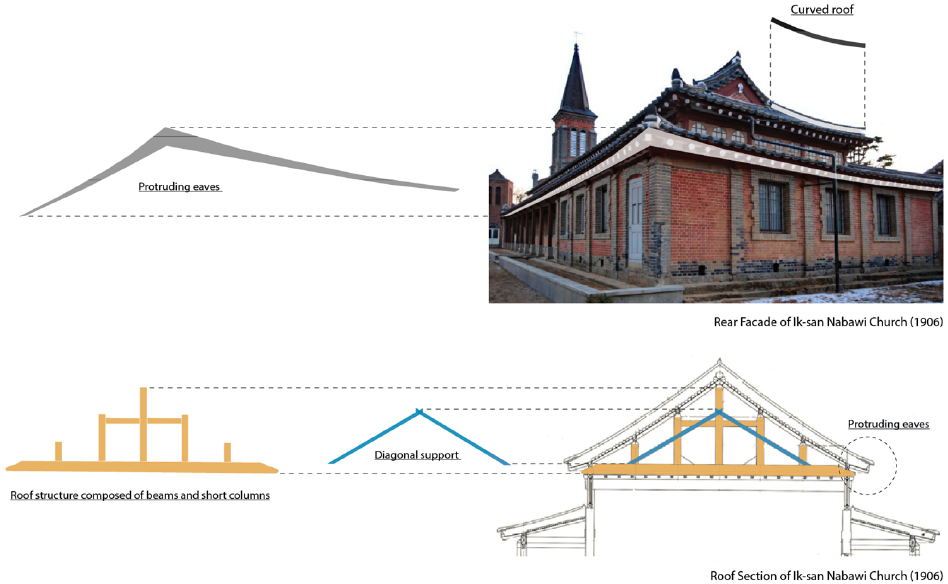
Figure 5. ( Top ) Characteristics of a Korean-style Roof Shown in the Exterior of Nabawi Church—Curved Roof and Eaves Space. ( Bottom ) Japanese Structure and Truss Principles Used in the Roof Structure of Nabawi Church—Diagonal Members.